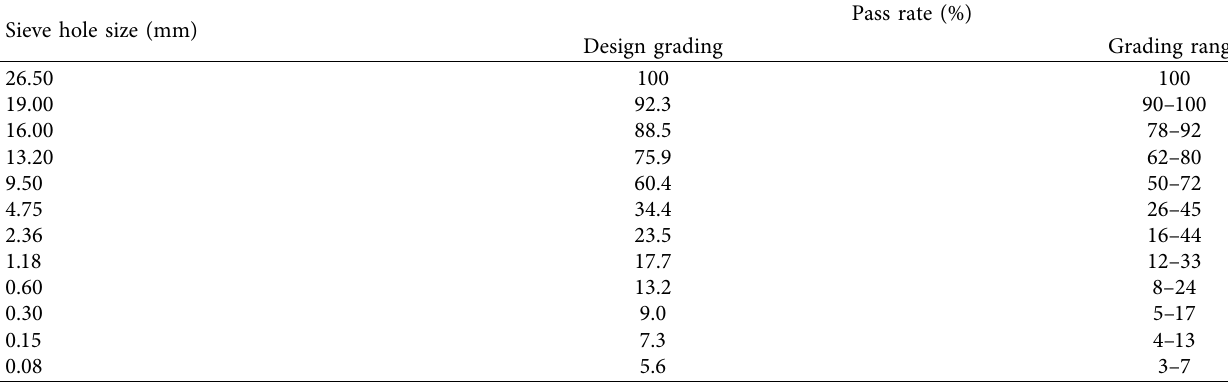
Table 5: Grade composition of rejuvenated asphalt mixture.